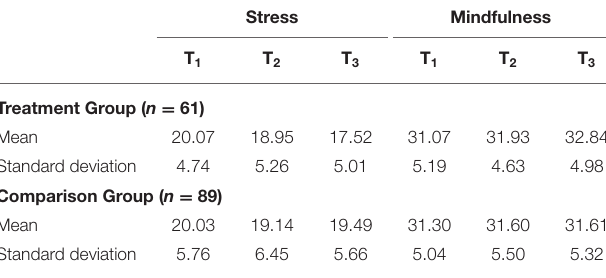
TABLE 2 | Univariate descriptive statistics for the perceived stress scale (PSS) and cognitive and affective mindfulness scale-revised (CAMS-R) by